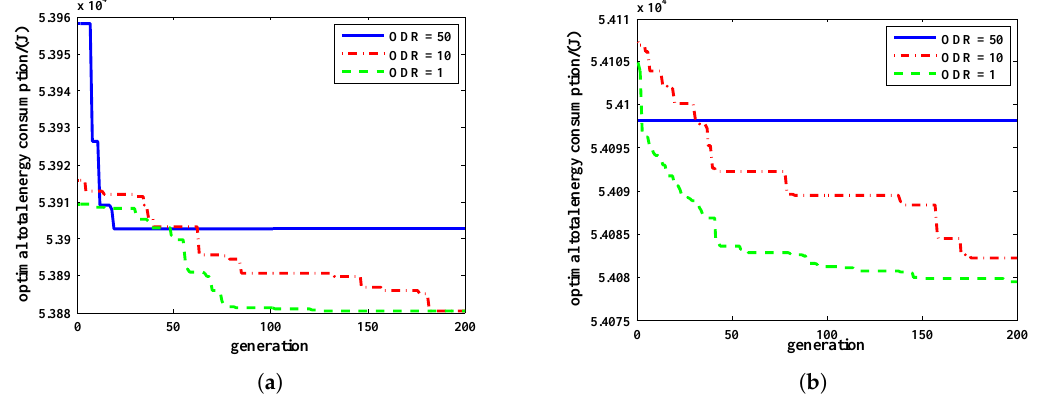
Figure 21. The optimal result of different ODR in the nouthern hemisphere. Panel ( a ) shows the optimal result in summer where the total energy consumption reduced by 12.6% and ( b ) shows the optimal result in winter where the total energy consumption reduced by